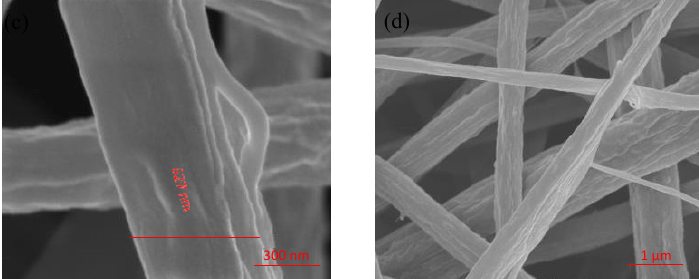
Figure 1. FESEM images of the nanofibers electrospun at: ( a ) 10 kV, ( b ) 15 kV, and ( c ) 18 kV, ( d ) Uniform nanofibers electrospun at 18 kV.